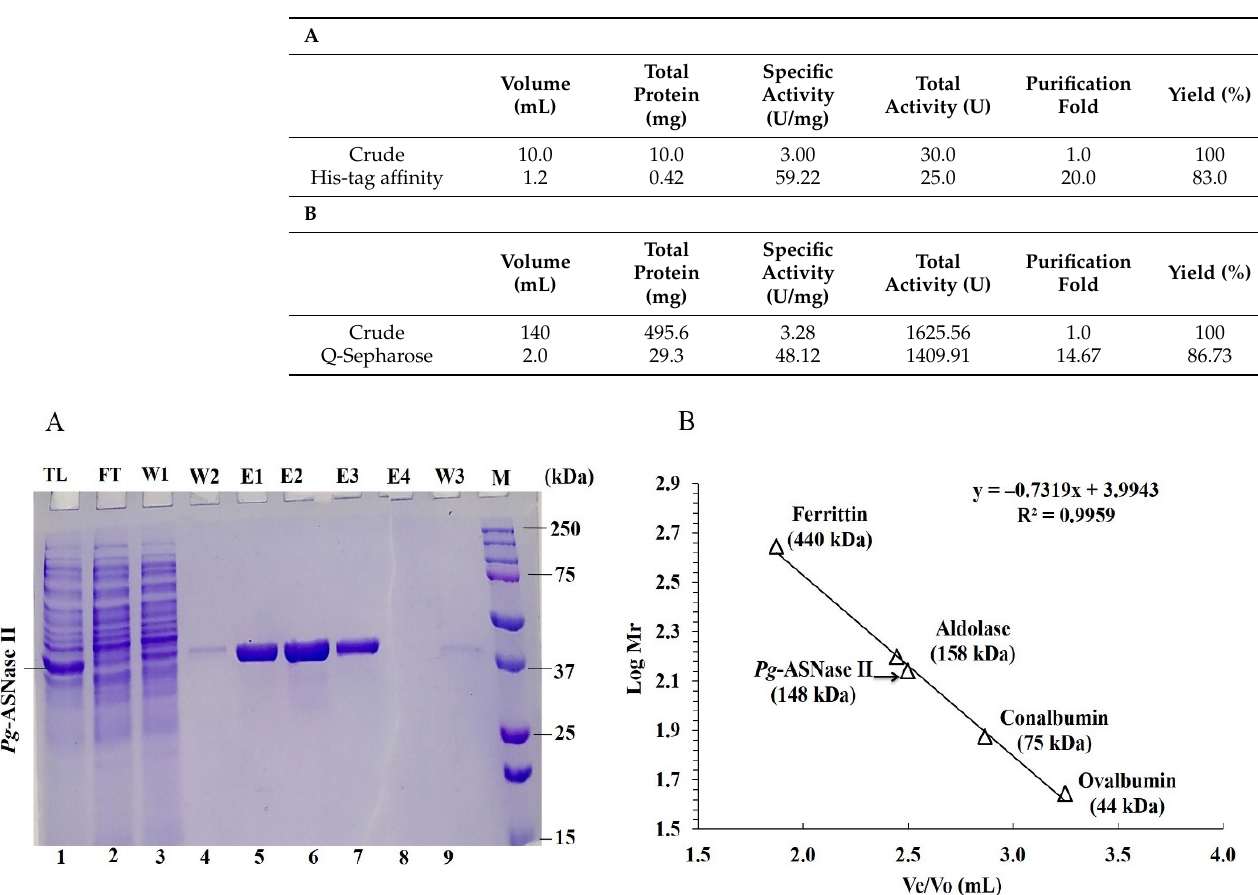
Table 1. Single-step purification for Pg -ASNase II. (A) Purification of His-tagged Pg -ASNase II using HisPur Cobalt resin column. (B) Purification of His-tagged free Pg -ASNase II using Q-Sepharose column.